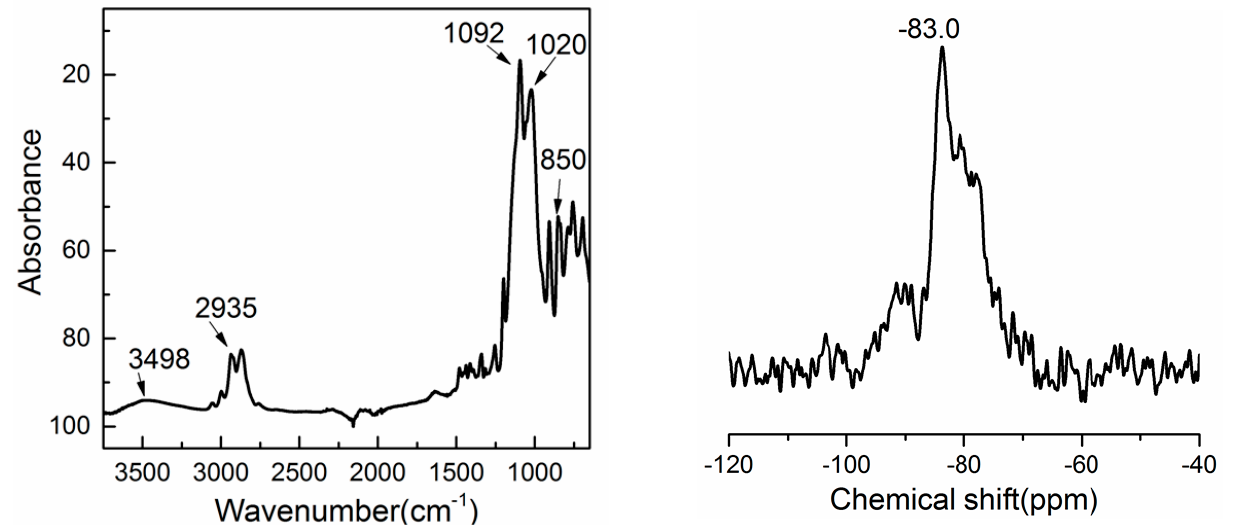
Figure 4. FT-IR ( left ) and Si NMR ( right ) spectra of EP-POSS.